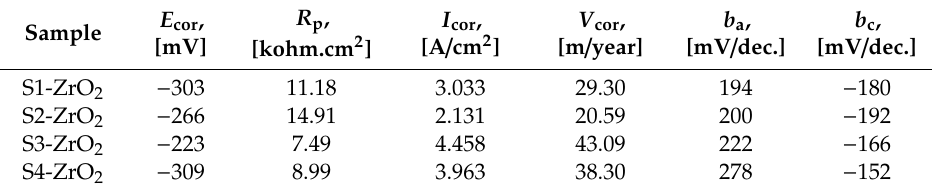
Table 6. Instantaneous corrosion parameters for coated samples in Ringer’s solution.